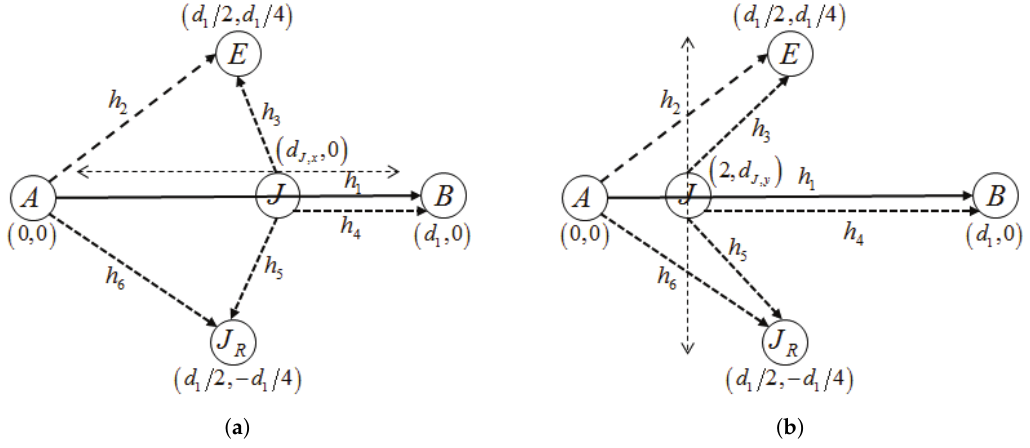
Figure 2. Network models used in the simulation: ( a ) the jammer moves horizontally; ( b ) the jammer moves